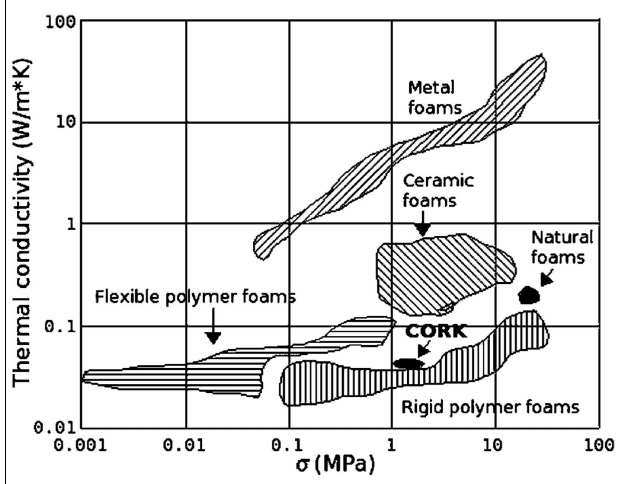
FIGURE 2 | Comparison between specific compressive strength ( σ / ρ ) and specific modulus ( E / ρ ) for cork and different foamed materials (Silva et al., 2005) .